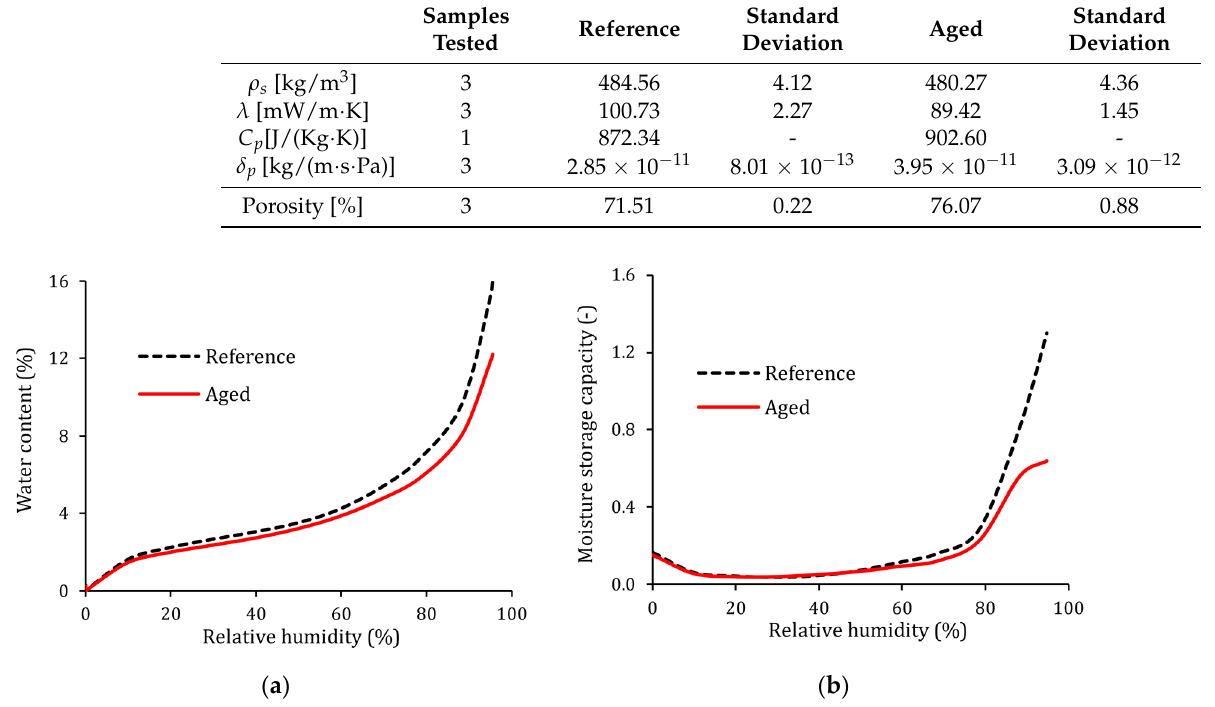
Figure 5. ( a ) Adsorption isotherm and ( b ) moisture storage capacity of aged and reference hemp concrete.